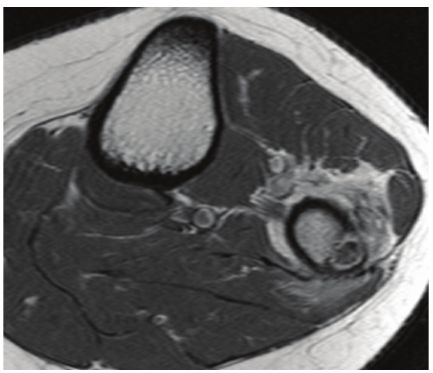
Figure 2: T1-weighted MRI scan showing the nidus surrounded by hyperintense